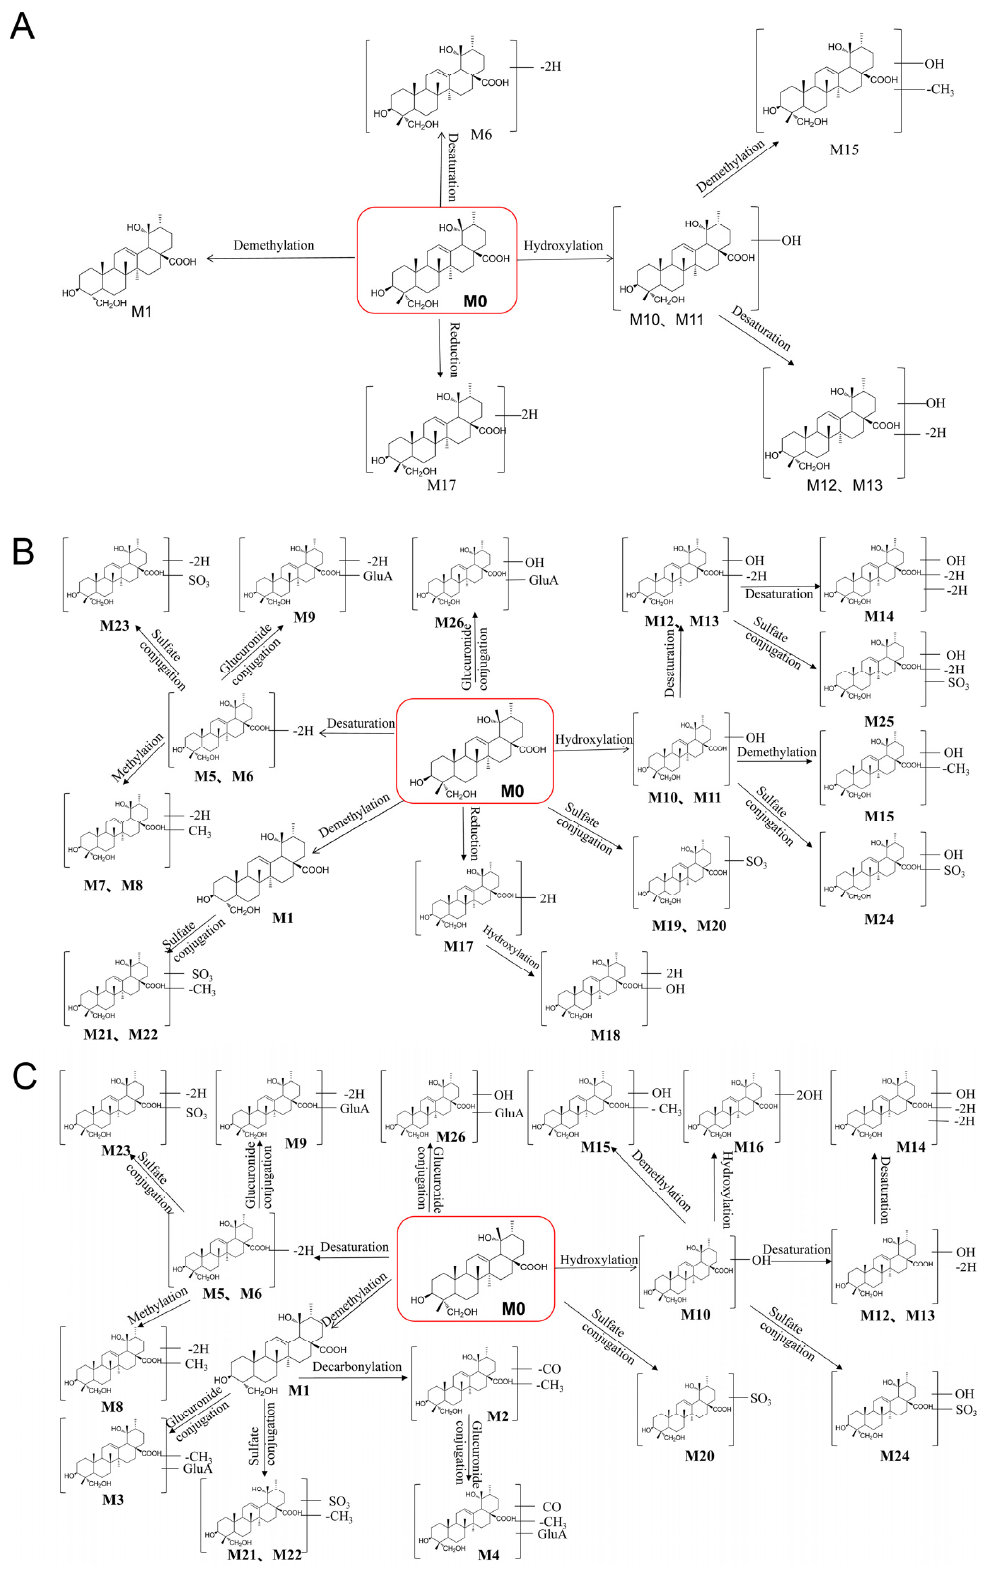
Figure 4. The proposed metabolic profiles of RA, in rat liver microsome ( A ), in normal rat ( B ), and in NAFLD rat ( C ).